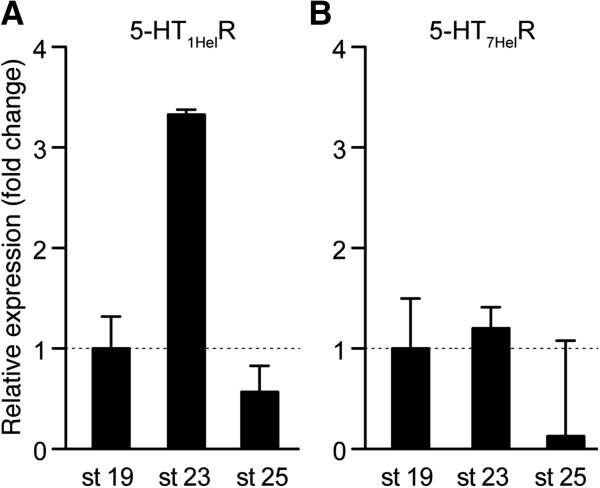
Expression of the 5-HT1 and 5-HT7 receptors is differently regulated during H. trivolvis development. Relative changes in the amount of mRNA encoding for the 5-HT1 and 5-HT7 receptors were determined at different developmental stages, including trochophore (st 19), shortly before metamorphosis (st 23) and in the middle of metamorphosis (st 25) using real time quantitative RT-PCR and ΔΔCt method. (A) The 5-HT1R is transiently unregulated at stage 23 only. (B) Relative expression of 5-НТ7R gradually down regulated by the metamorphic stage (st 25).